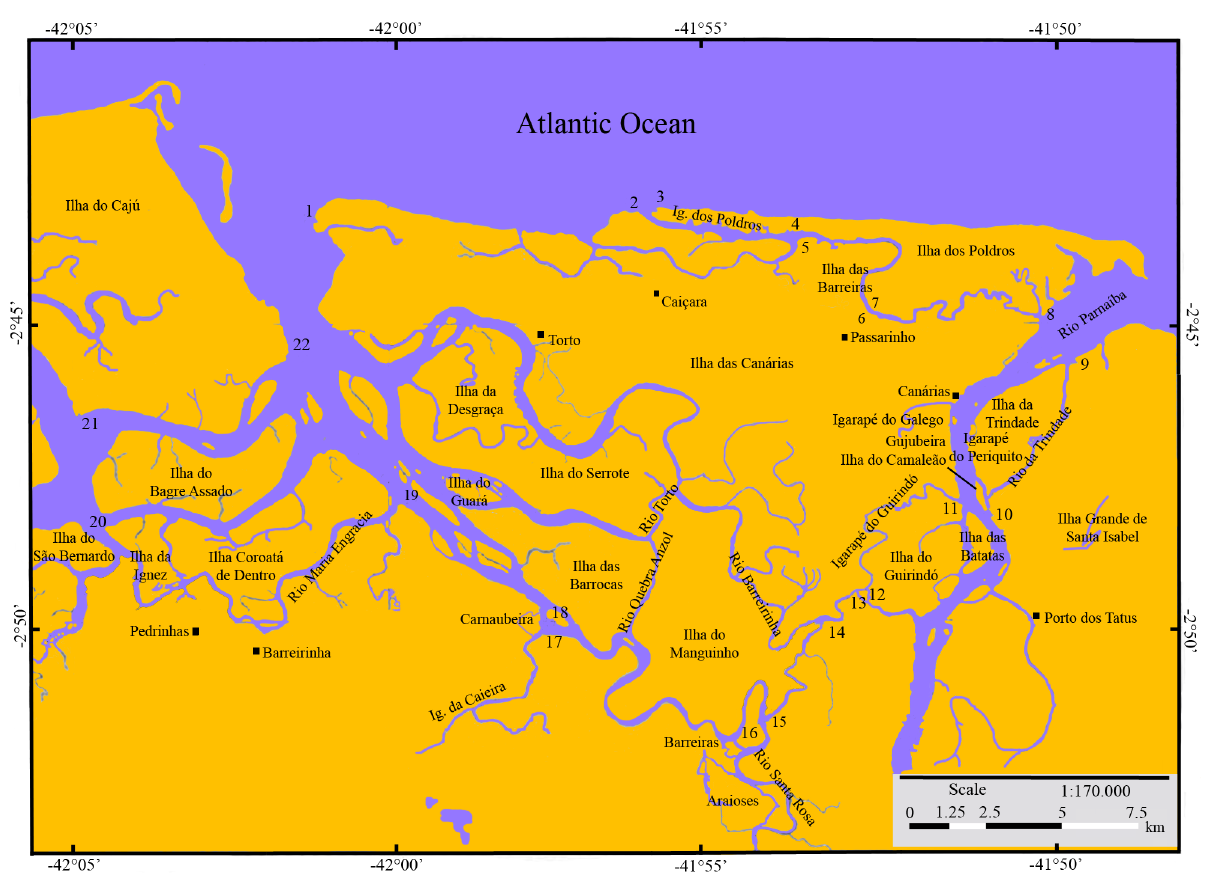
Figure 3. Location map of Ucides cordatus sites in the Parnaíba River Delta, Brazil. N = 84. Source: adapted from ICMBio (2016).